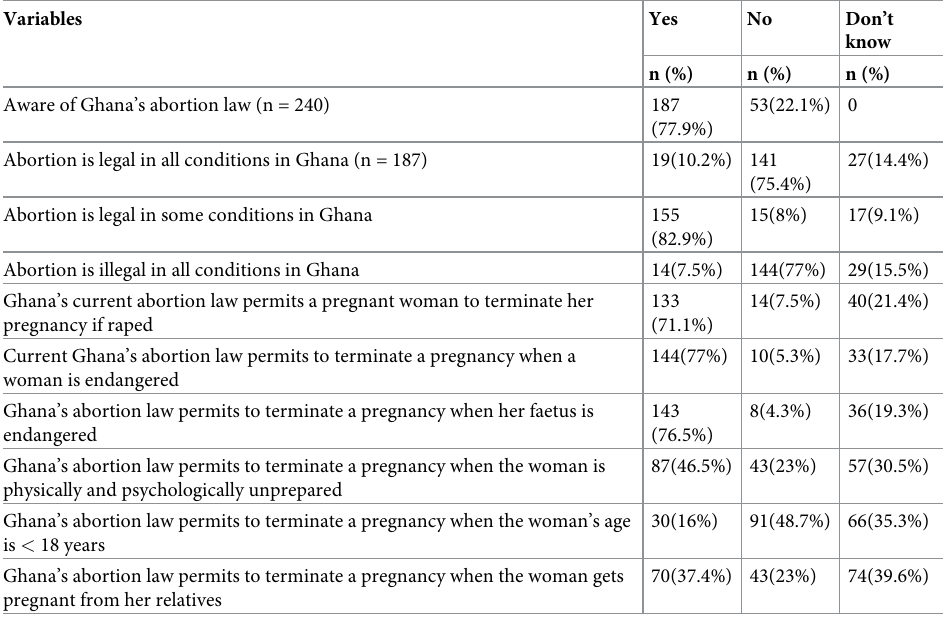
Table 3. Abortion law-related knowledge among